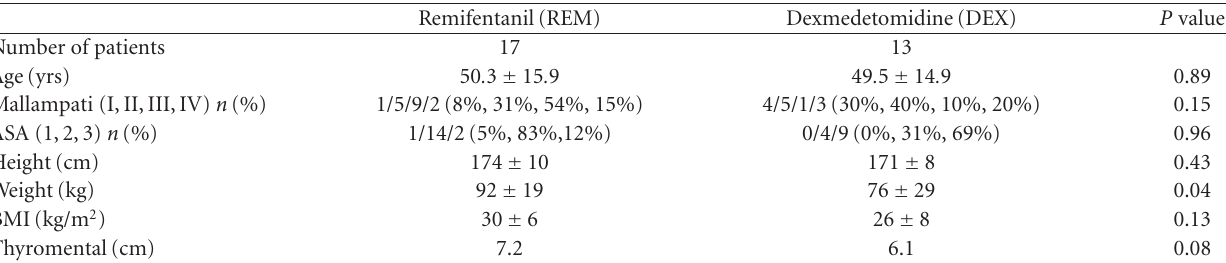
Table 2: Patient demographics between the two